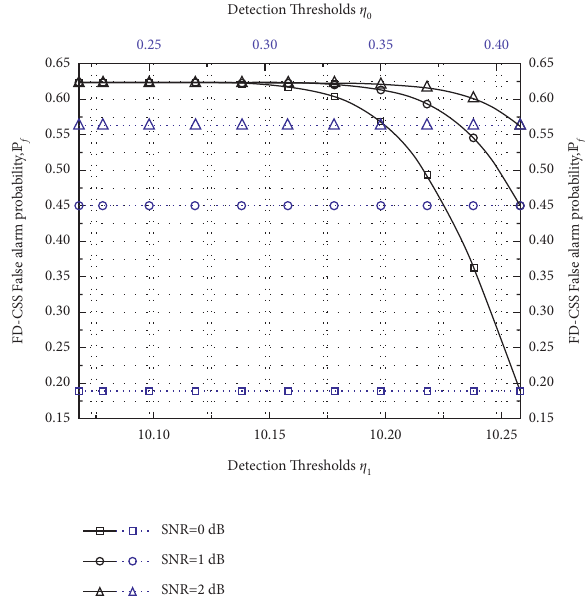
Figure 2: FD-CSS false alarm probability versus relative threshold. The lines and markers denote the results from the analysis and simulations,